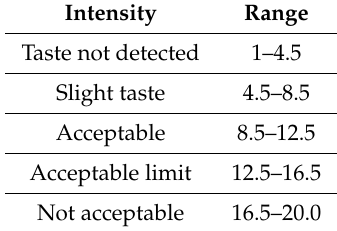
Figure 1. Estimated electronic tongue bitter scores of glycated protein hydrolysates and their ability to suppress quinine bitterness intensity: AH-AGEs, glycated alcalase hydrolysate ( A ); ( B ) CH-AGEs, glycated chymotrypsin hydrolysate ( B ). BCML (N α , N α -bis(carboxymethyl)-Llysine) was used as a positive control. Bars with different letters have significantly different ( p < 0.05) mean values as determined from Duncan Multiple Range tests while error bars represent standard deviation. Table 3. Bitter intensity level with corresponding scores from the human taste evaluation panelists*.